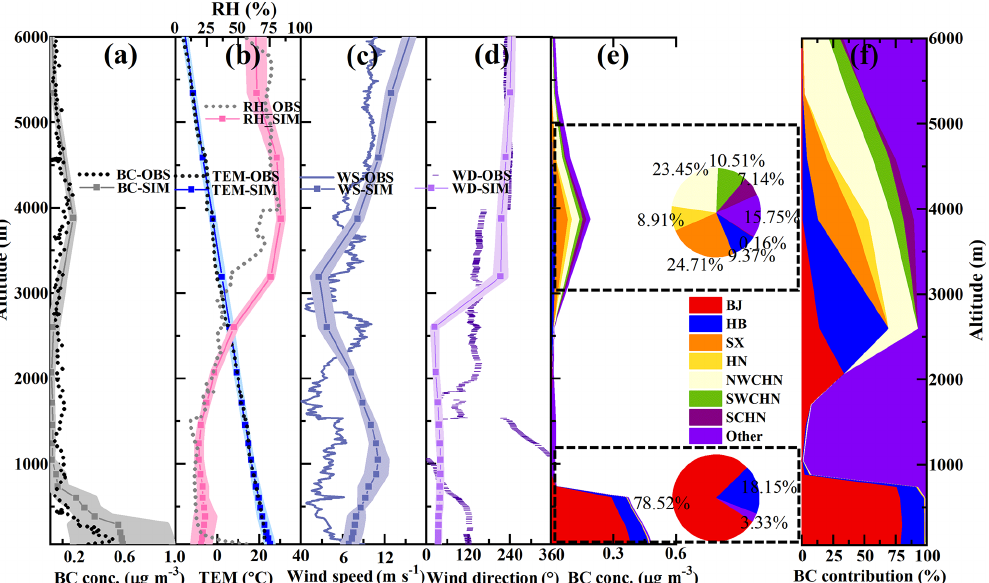
Figure 6. Model validation of (a) vertical BC, (b) T and RH, (c) WS, (d) WD, (e) BC concentration of each source region, and (f) contribution rate of each source region at 10:00–12:00BJT on 5 May. The shading indicates the modelling standard deviation. The legend refers to the regions shown in Fig.